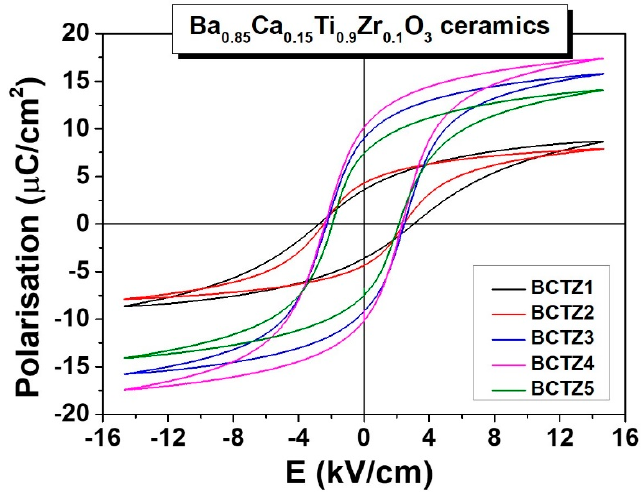
Figure 4. P ( E ) hysteresis loops of BCTZ ceramics determined under an input cycling field (sine wave) with the amplitude of 15 kV/cm and the frequency of 1 Hz.